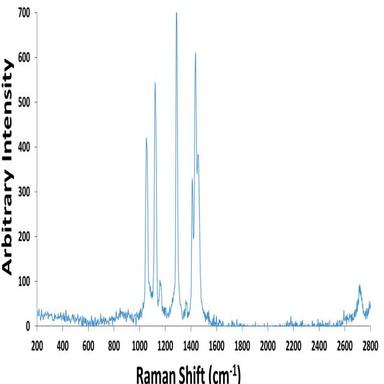
Contact probe Raman spectra of HDPE measured over 16 m of optical fibres.